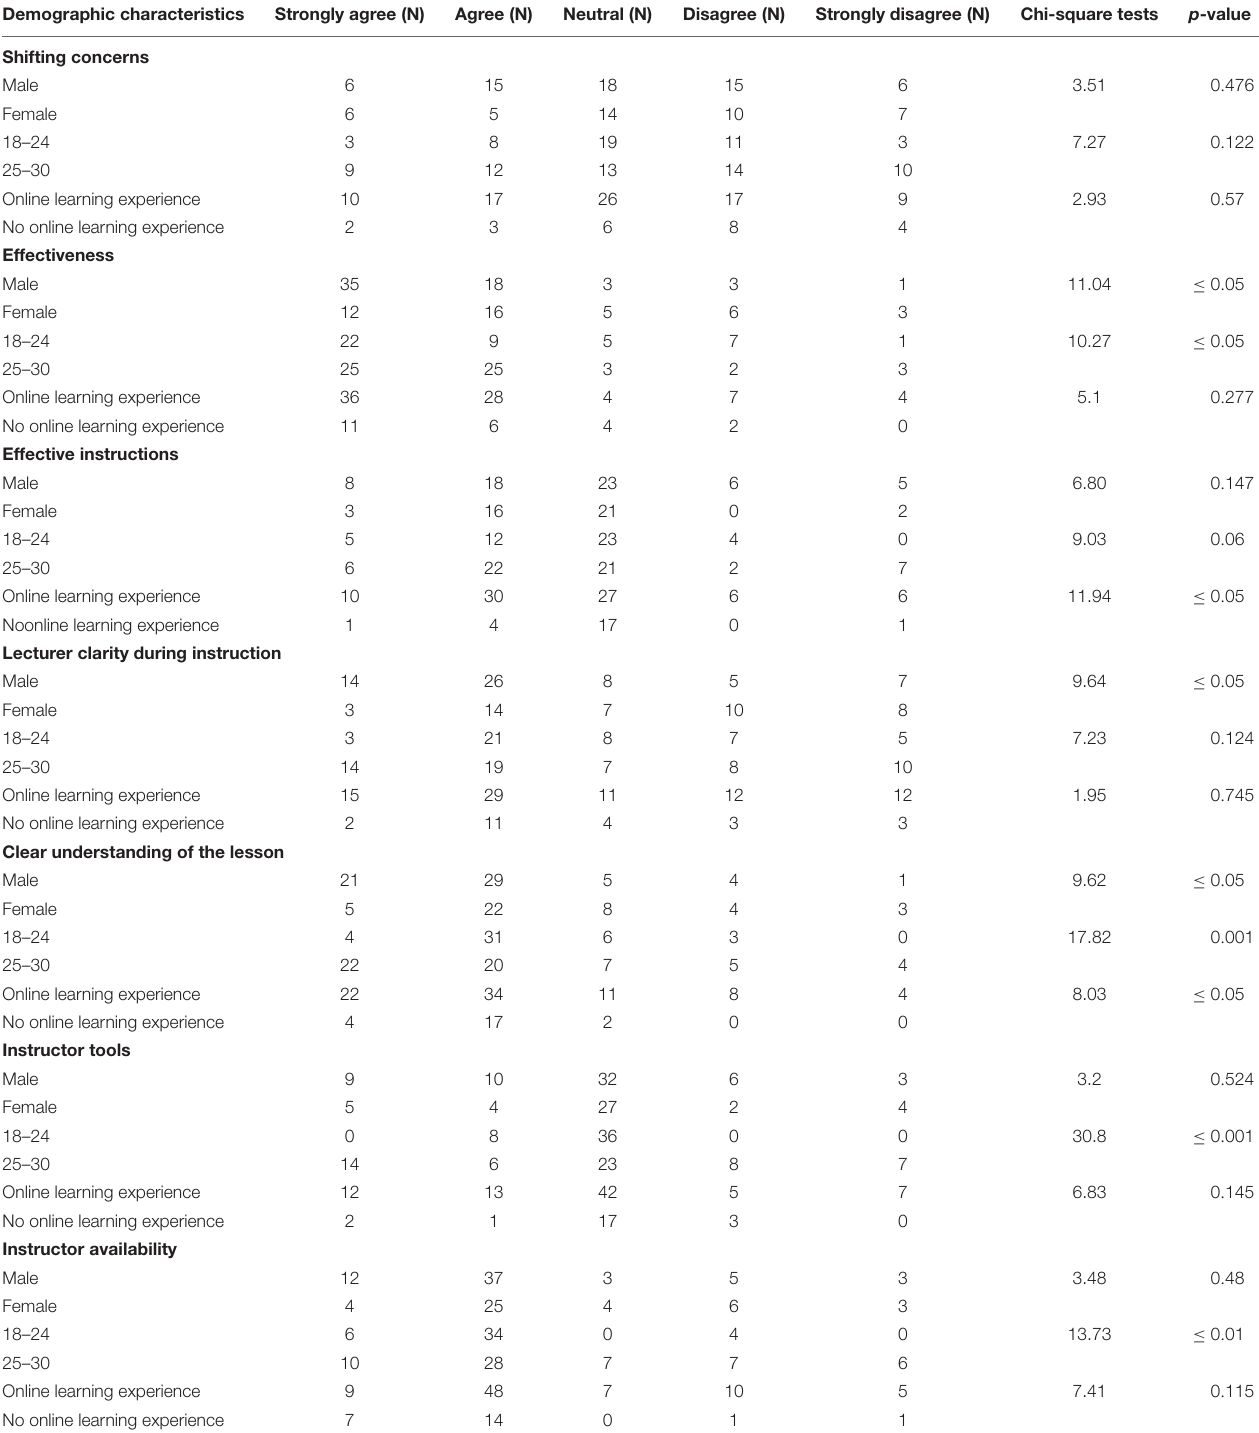
TABLE 4 | Comparison of demographic characteristics and different parameters for online learning. Demographic